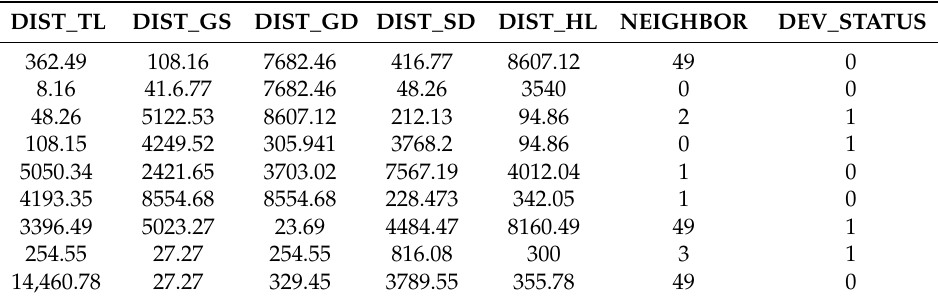
Table 3. Sample Data.